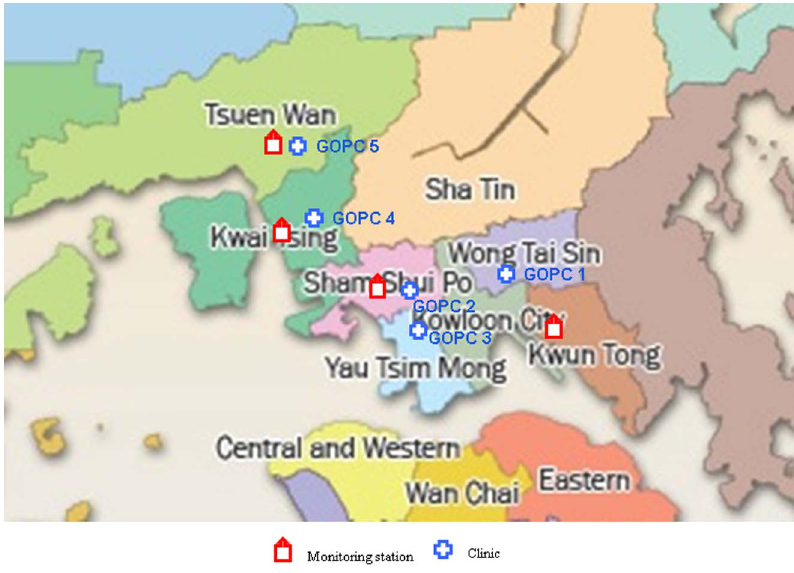
Figure 1. A location map of GOPCs and the air monitoring stations.